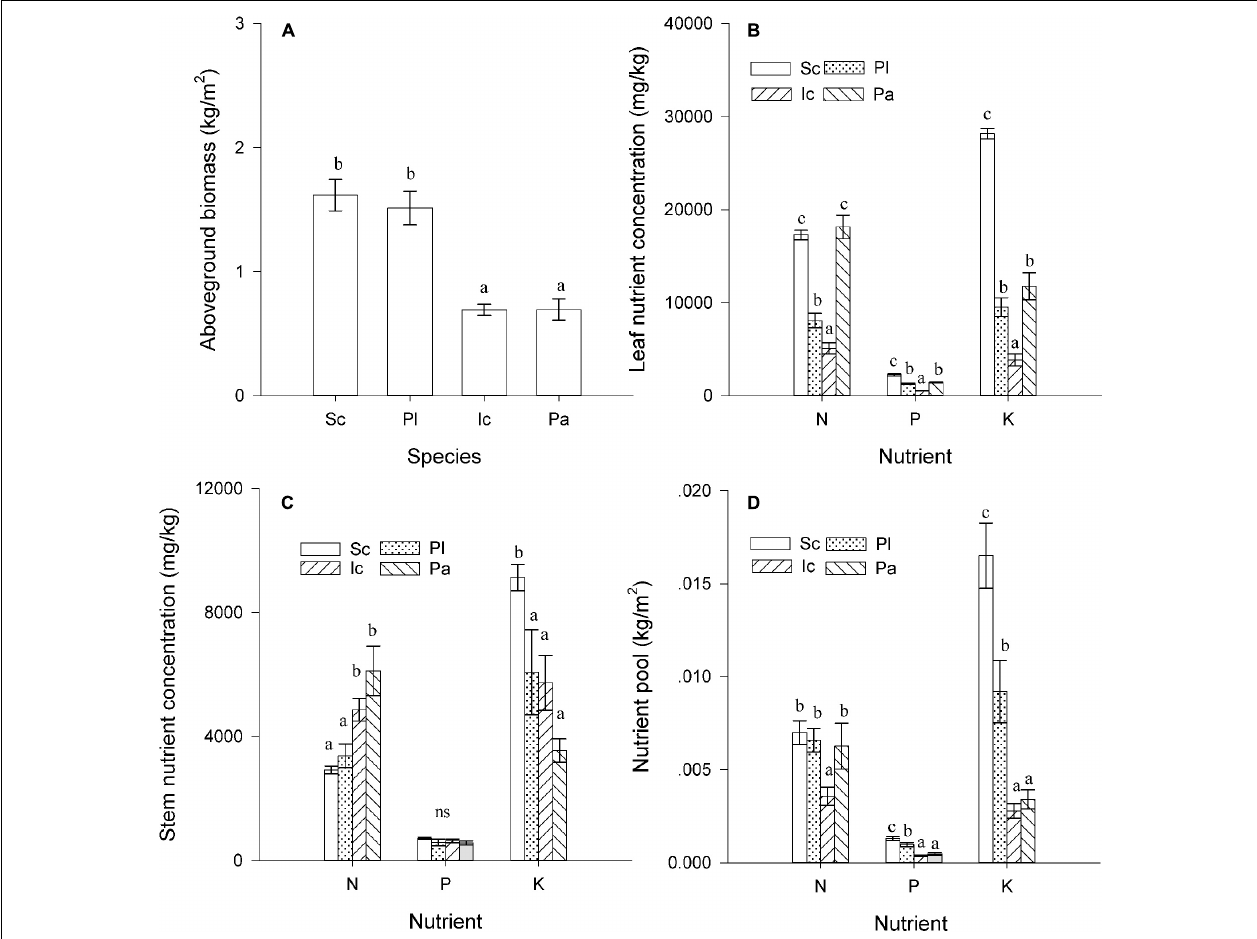
FIGURE 2 | Nutrients accumulation in the aboveground stands. (A) Aboveground biomass (Kg/m 2 ). (B) Nutrient (N, P, and K) concentrations (mg/g) in leaves. (C) Nutrient (N, P, and K) concentrations (mg/g) in stems (C) . (D) Nutrient (N, P, and K) pools (g/m 2 ) in aboveground biomass (g) of the four dominant species. Sc, Pl, Ic, and Pa stand for S. canadensis , P. latifolius , I. cylindrical, and P. australis, respectively. Bars and vertical lines are means ± SE. Different letters indicate significant differences between the species ( P =